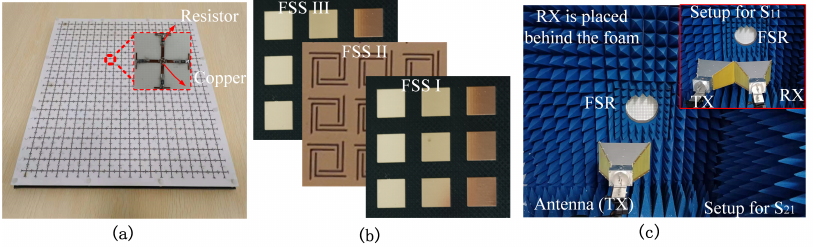
Figure 8. Photograph of the proposed FSR and measurement environment: ( a ) FSR prototype; ( b ) metallic patches and rotating aperture; ( c ) measurement